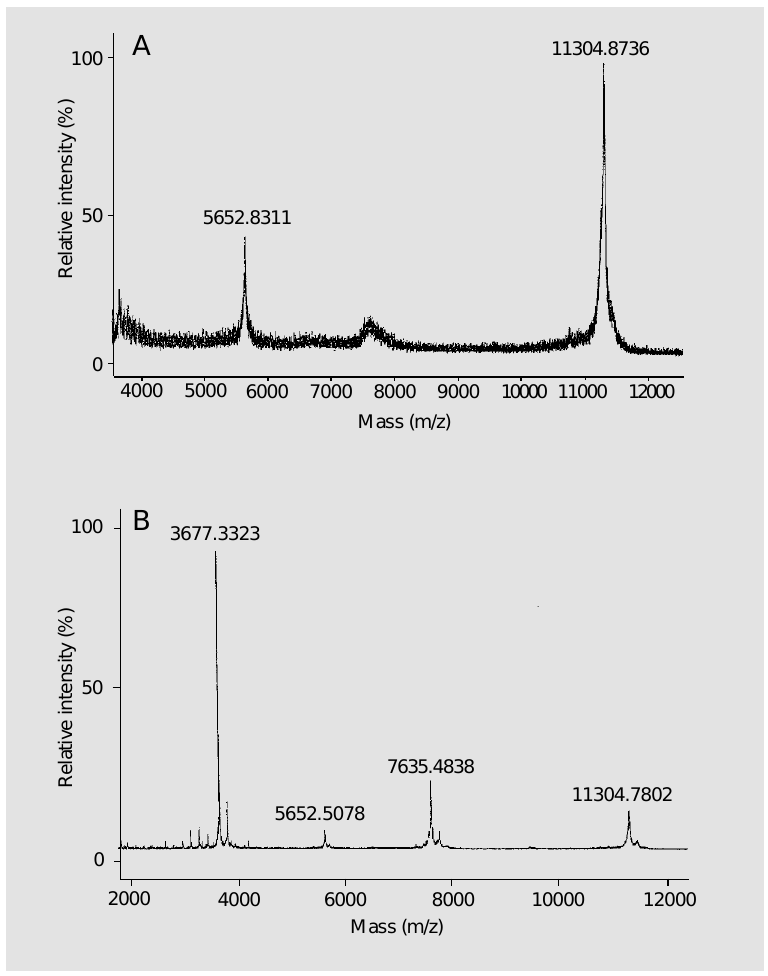
Figure 2 - A , MALDI-TOF mass spectrum of native cactin. B , MALDI-TOF mass spectrum of cactin after reduction with DTT.